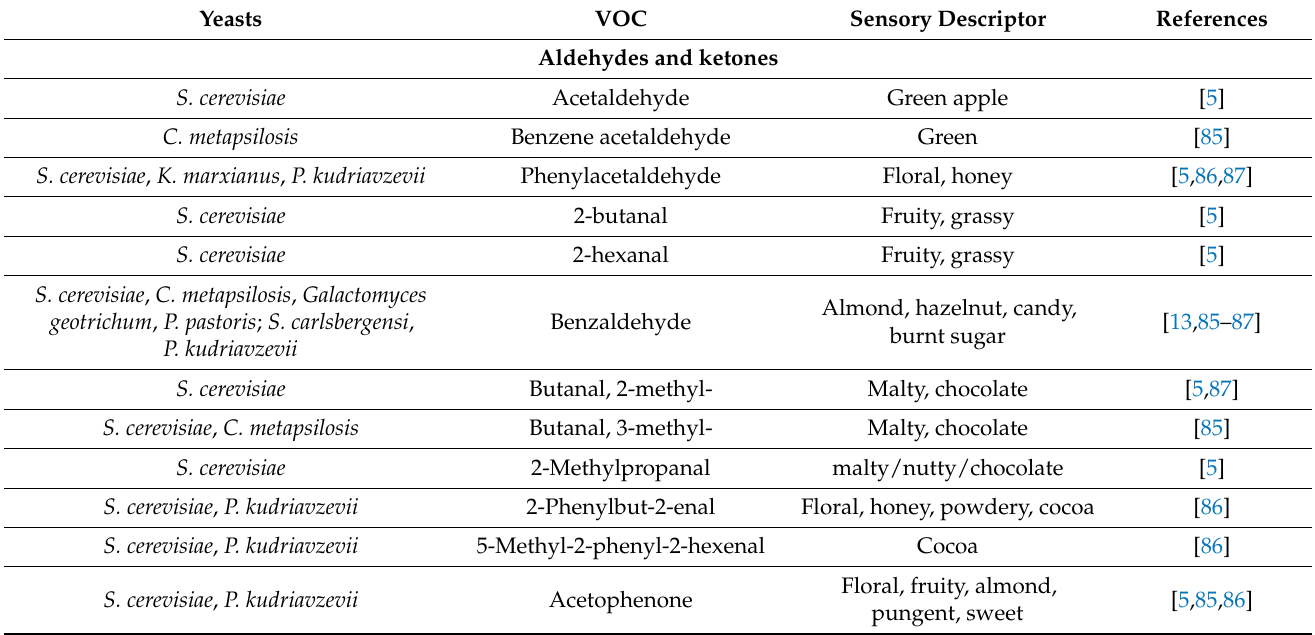
Table 1. Main VOCs and sensory descriptors produced by yeasts in cocoa bean